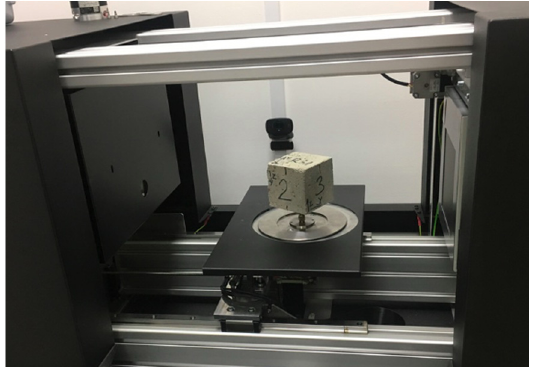
Figure 7. Determination of the distribution of ISF and RSF fibres in the samples of concrete composites using 3D Skyscan 1173 X-ray microtomography.